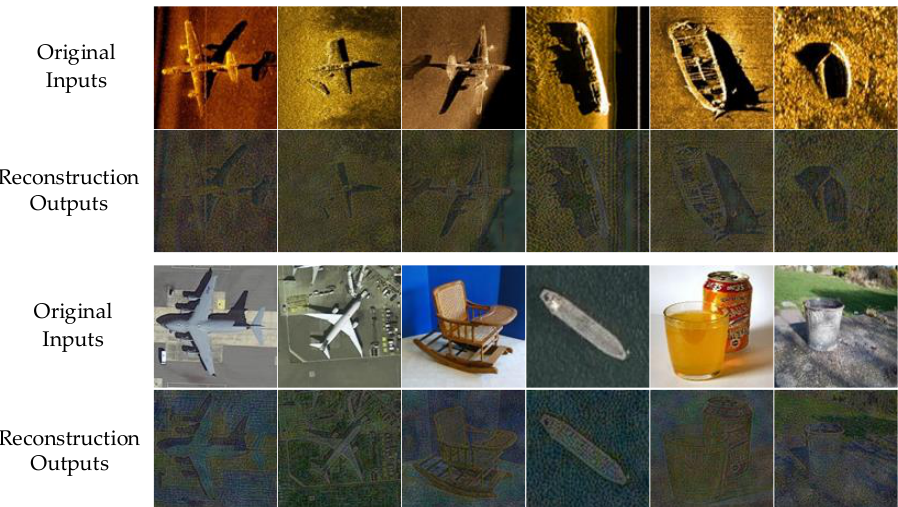
Figure 9. Decoded results of the pure Gaussian noise as deep features; the inputs are the same as those in Figure 6.